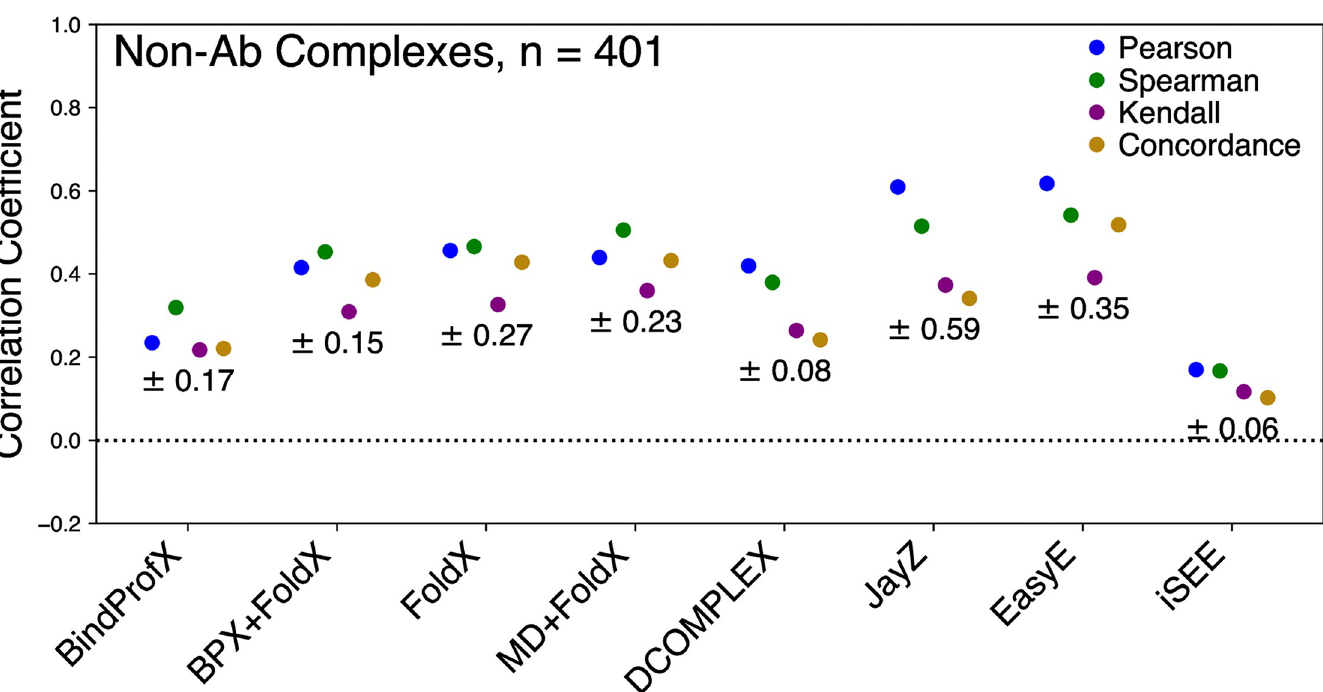
Fig 2. Performance of each method for non-Ab complexes (401 total mutations) in predicting true ΔΔ G values ( ρ c ), linearly correlated ΔΔ G values ( r ), and rank order ( ρ and τ ). The error for each method is reported under the correlation